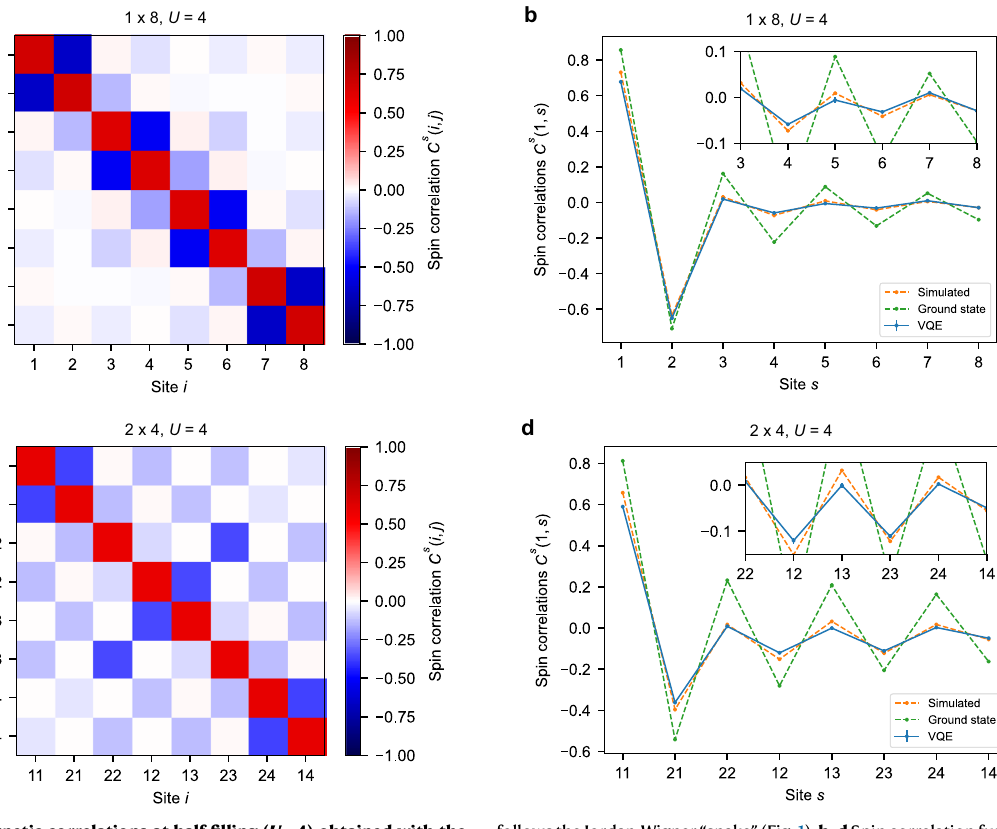
followstheJordan-Wigner “ snake ” (Fig.1). b , d Spincorrelationfunction C s (1, s )fora 1×8 ( b ) and 2×4 ( d ) system. The meaning of labels in b , d is as in Fig.